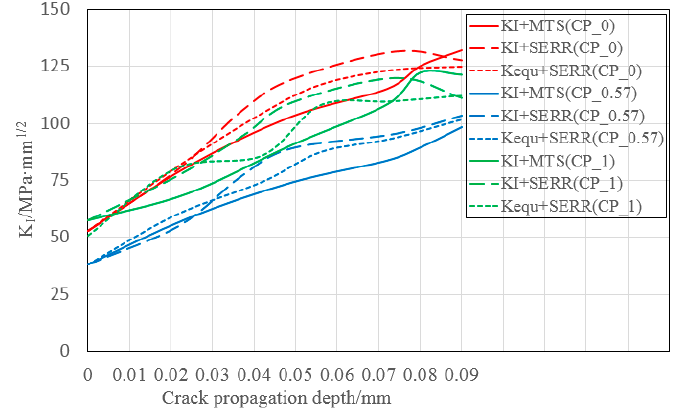
Figure 14. Evolution of K I of characteristic points (Stage 1).